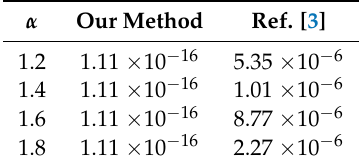
Table 3. Comparison of the maximum absolute errors (MAEs) of Problem 2 with [3] for different values of α .